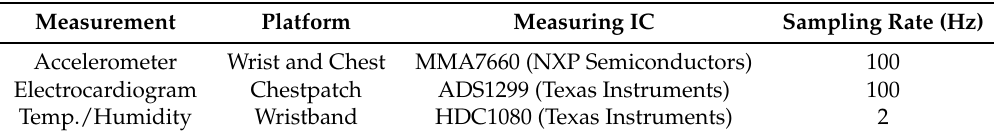
Table 1. HET Sensors with Sampling